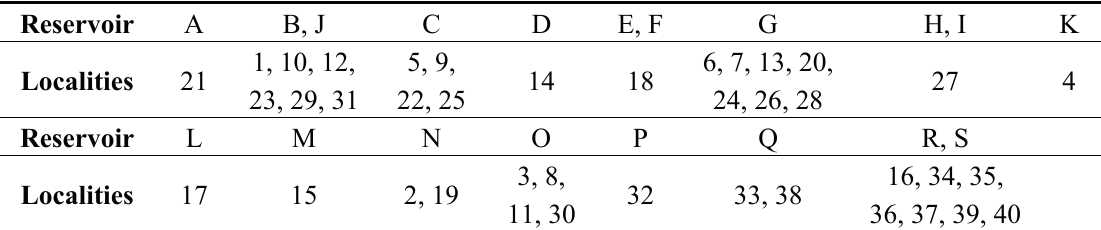
Figure 1. Map of the Maltese Islands showing the location of the samples taken from localities (marked in red) and supply reservoirs (marked in green). The Maltese Archipelago consists of two main inhabited islands: Malta and Gozo. Table 2. List of localities and their corresponding reservoir